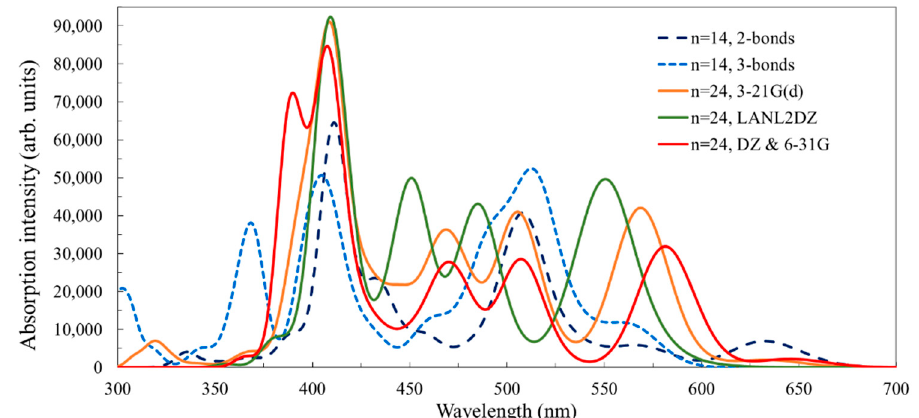
Figure 11. Simulated UV–Vis absorption spectra of the systems consisting of the C343 dye molecule adsorbed on the Ti n O 2 n +2 H 4 clusters, calculated in water solvent by TD-DFT at the B3LYP/LANL2DZ level for n = 14. For n = 24, the calculations were performed with the LANL2DZ basis set on the geometry optimized with 3-21G(d) or LANL2DZ and a combination of LANL2DZ for Ti atoms and 6-31G(d,p) for on O, C, N, and H atoms (DZ & 6-31G) on the structure determined with the same functions. The spectral lines were convoluted with Gaussian distributions of 1000 cm − 1 full width at half maximum.